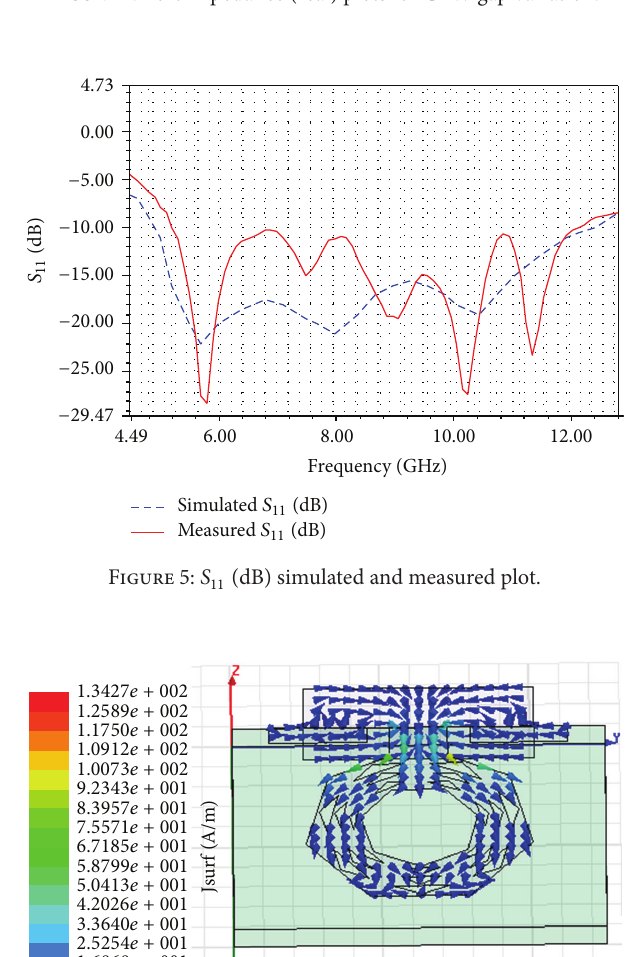
Figure 4: Port impedance (real) plots for CPW gap variation.